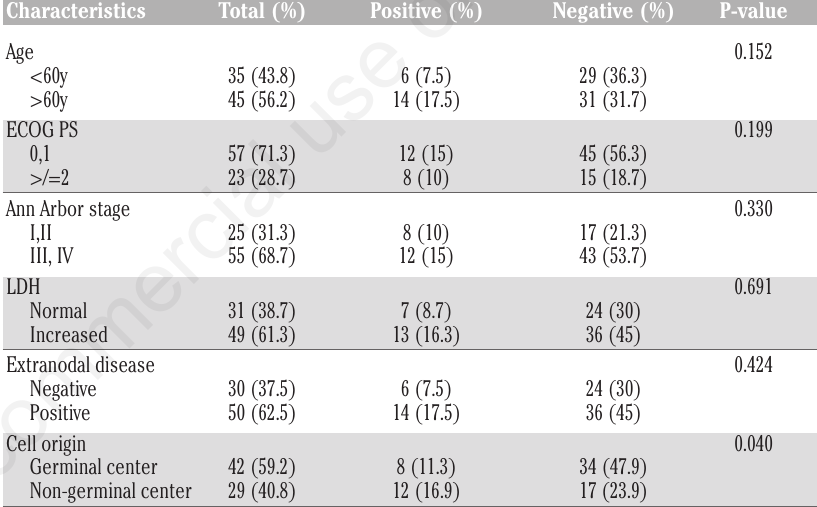
Figure 2. Survival curves of patients grouped according to the OPN Table 1. Correlation of osteopontin expression with clinical-pathological characteristics.